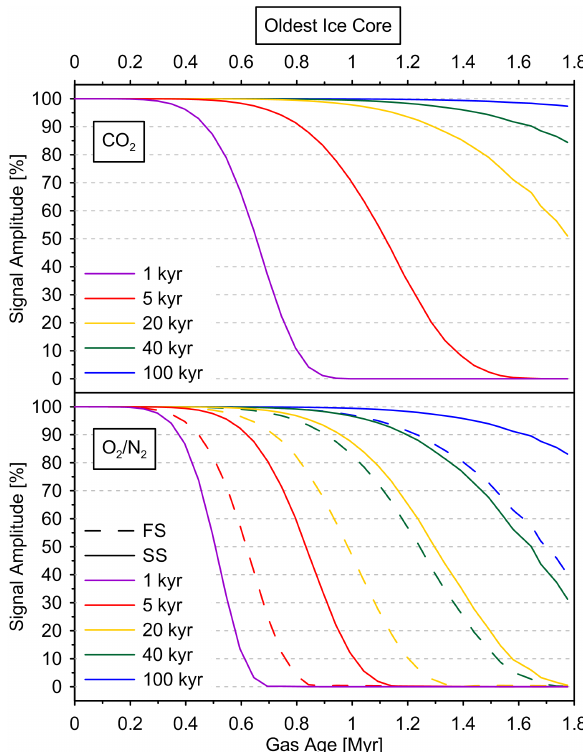
Fig. 8. Simulated amplitude dampening of CO 2 concentration (top) and O 2 /N 2 ratio (bottom) signals for the oldest ice core ice flow and temperature profile (Fig. 1). The different coloured lines show the results for different periods of the signal as indicated by the